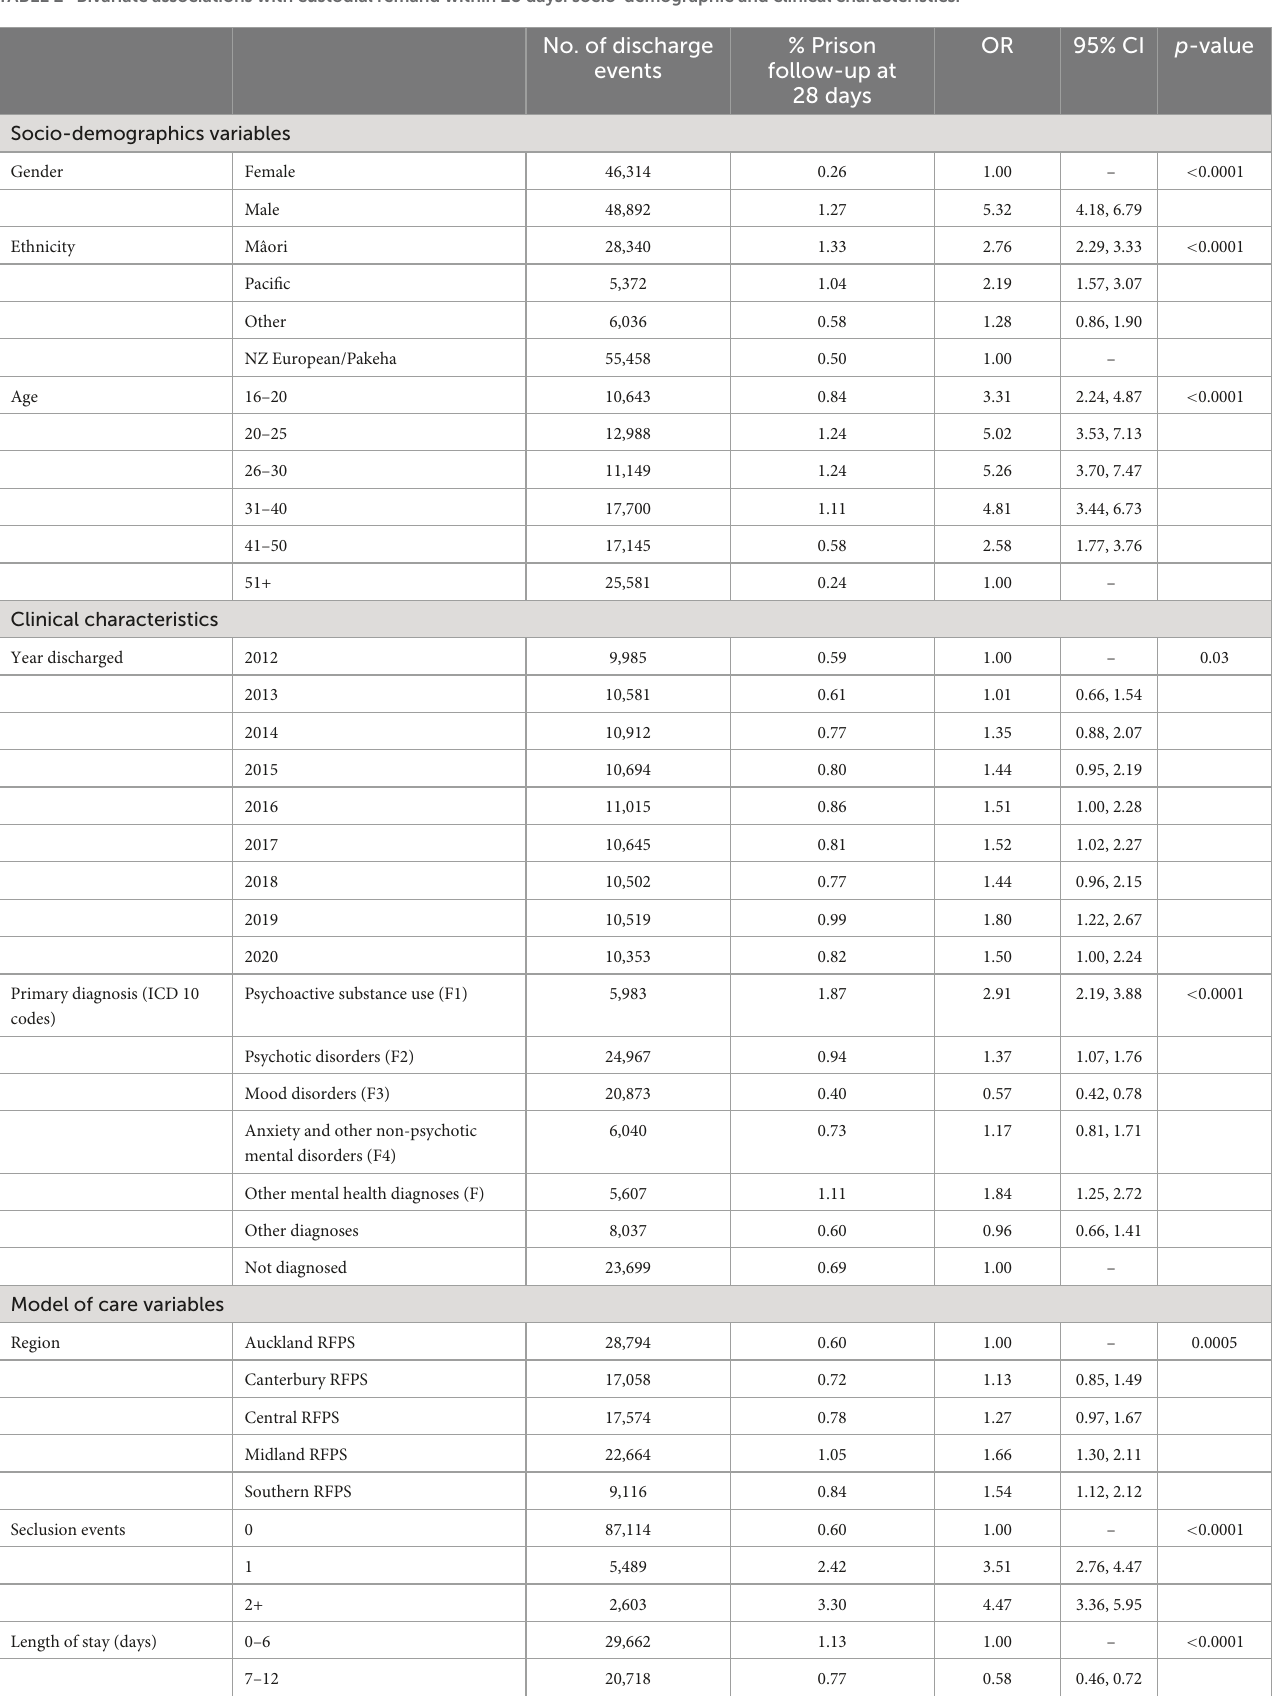
TABLE 2 Bivariate associations with custodial remand within 28 days: socio-demographic and clinical characteristics.